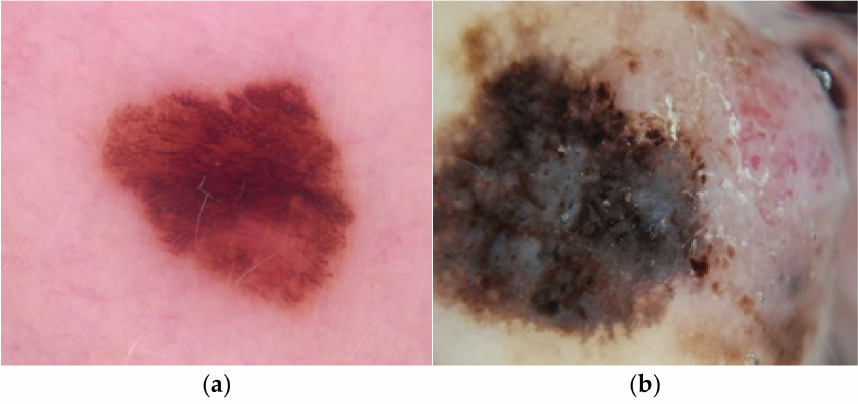
Figure 1. Sample imaging of skin cancer: ( a )—benign lesion, ( b )—malignant lesion